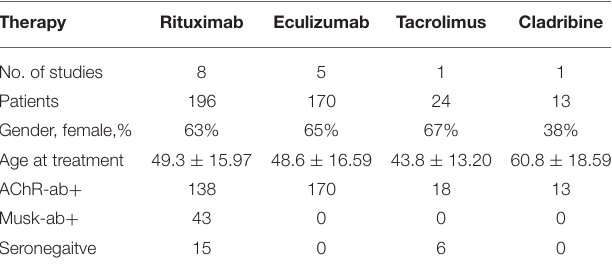
TABLE 2 | Clinical characteristics of patients treated with rituximab, eculizumab, tacrolimus, and